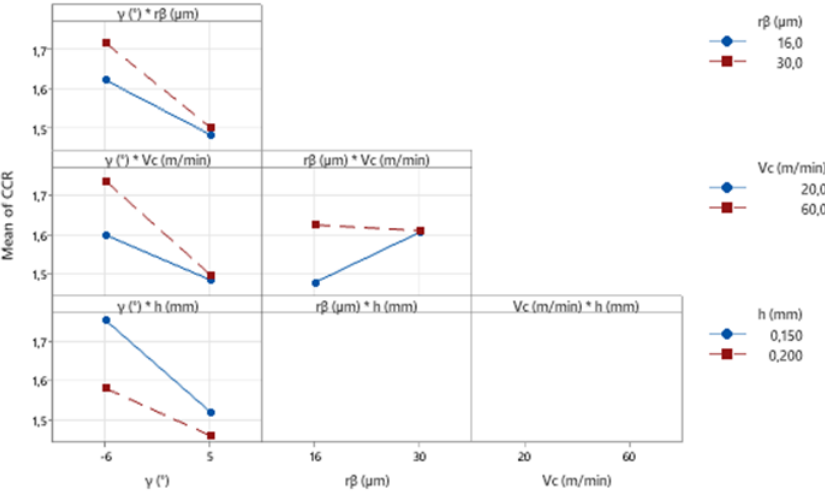
Figure 10. Influence of the interactions between cutting parameters on the CCR based on all cutting conditions.